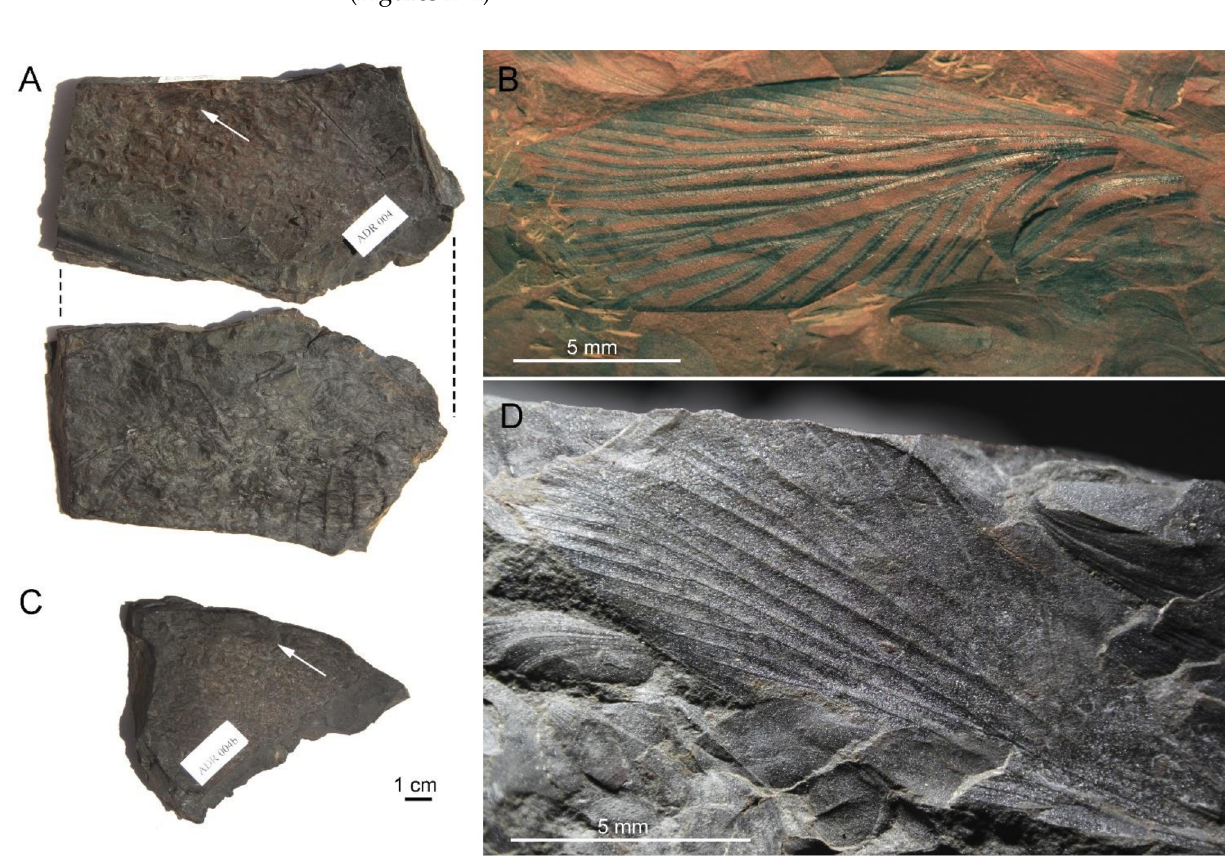
Figure 2. Specimen of Sysciophlebia ‘sp. form Villablino’ (Spiloblattinidae), forewing from Orallo mine (Villablino, Le ó n Province). ( A ) Two sides of slab containing part, MGM-814Ha (white arrow). ( B ) Wing part, under alcohol. ( C ) Slab with counterpart, MGM-814Hb (white arrow). ( D ) Wing counterpart. Note the abundant bivalve shells on sides A, having the part and counterpart of the fossil wing, and abundant plant remains on reverse. Images ( A , C ) to the same